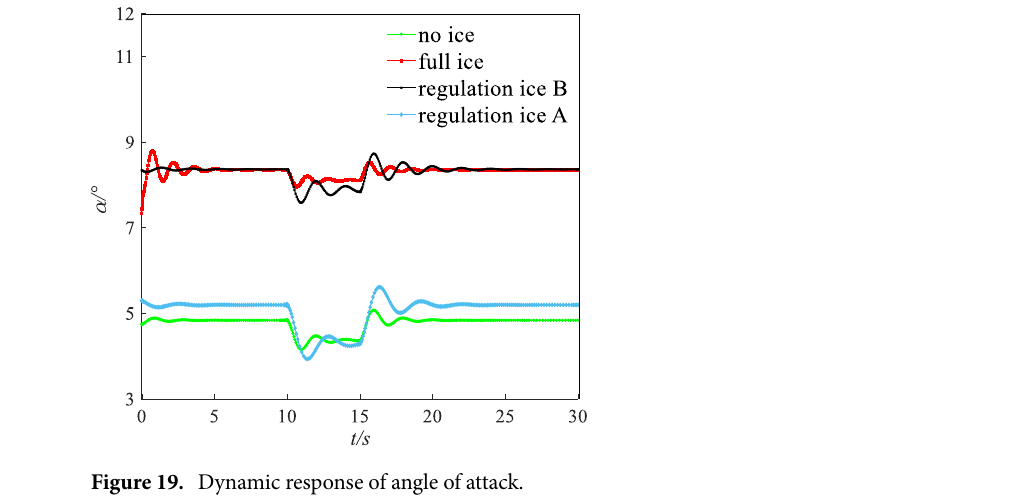
Figure 19. Dynamic response of angle of attack.